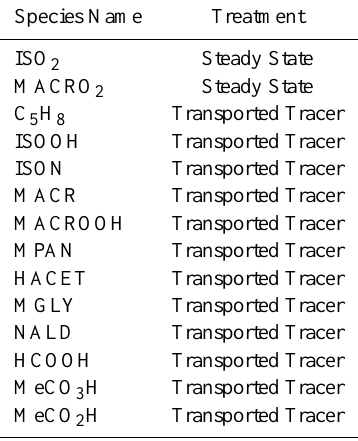
Table 7. Additional tracers/species associated with the Mainz Isoprene Mechanism in the UKCA TropIsop chemistry scheme, where Me = CH 3 , IS = C 5 H 7 , ISON = lumped peroxy alkyl ni- trates (from C 5 H 8 +NO 3 ) and hydroxy alkyl nitrates (from ISO 2 + NO), MACR = lumped species consisting of methacrolein, methyl vinyl ketone and other C 4 carbonyls from isoprene ox- idation, MPAN = peroxy methacrylic nitric anhydride (and other higher PANs from isoprene chemistry), HACET = hydroxyacetone and other C 3 ketones, MGLY = methylglyoxal and other C 3 car- bonyls, and NALD = nitrooxy acetaldehyde.